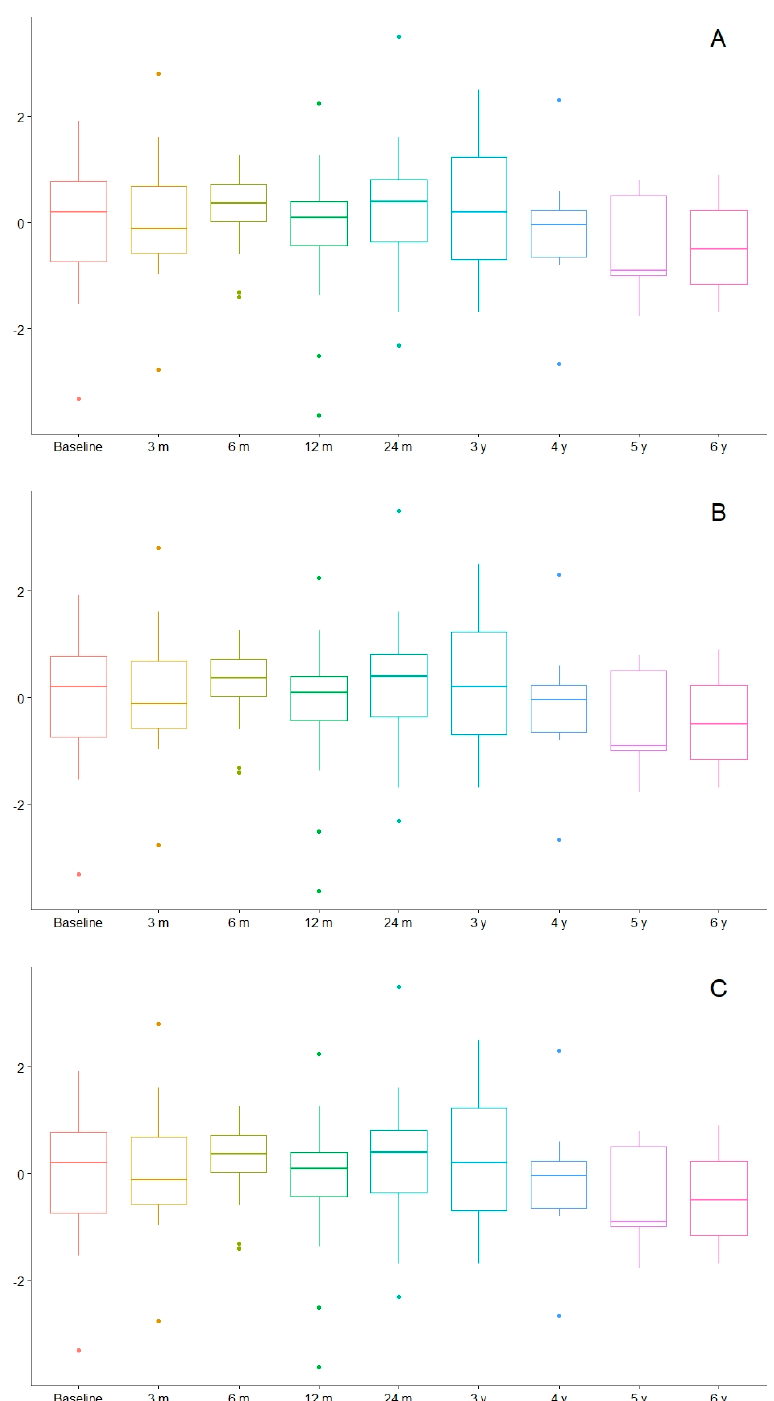
Figure 3. Evolution of weight ( A ), height ( B ), and BMI ( C ) in z-score values. m: months, y: years. Vitamin E stayed within normal ranges during the entire follow-up, six patients had vitamin A deficiency (1 at 12 months (0.18 mg/L), one at 2 years (0.19), two at 3 years (0.16 and 0.19), and two at 4 years (0.17 and 0.12)), and six had vitamin D deficiency (one at 3 months (19.3 ng/mL), two at 12